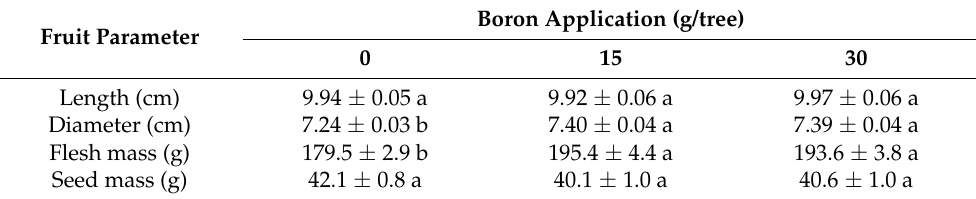
Means ± SE within a row with different letters are significantly different (generalised linear models, p < 0.05, n = 160 fruit for length, diameter, and seed mass, n = 80 fruit for flesh